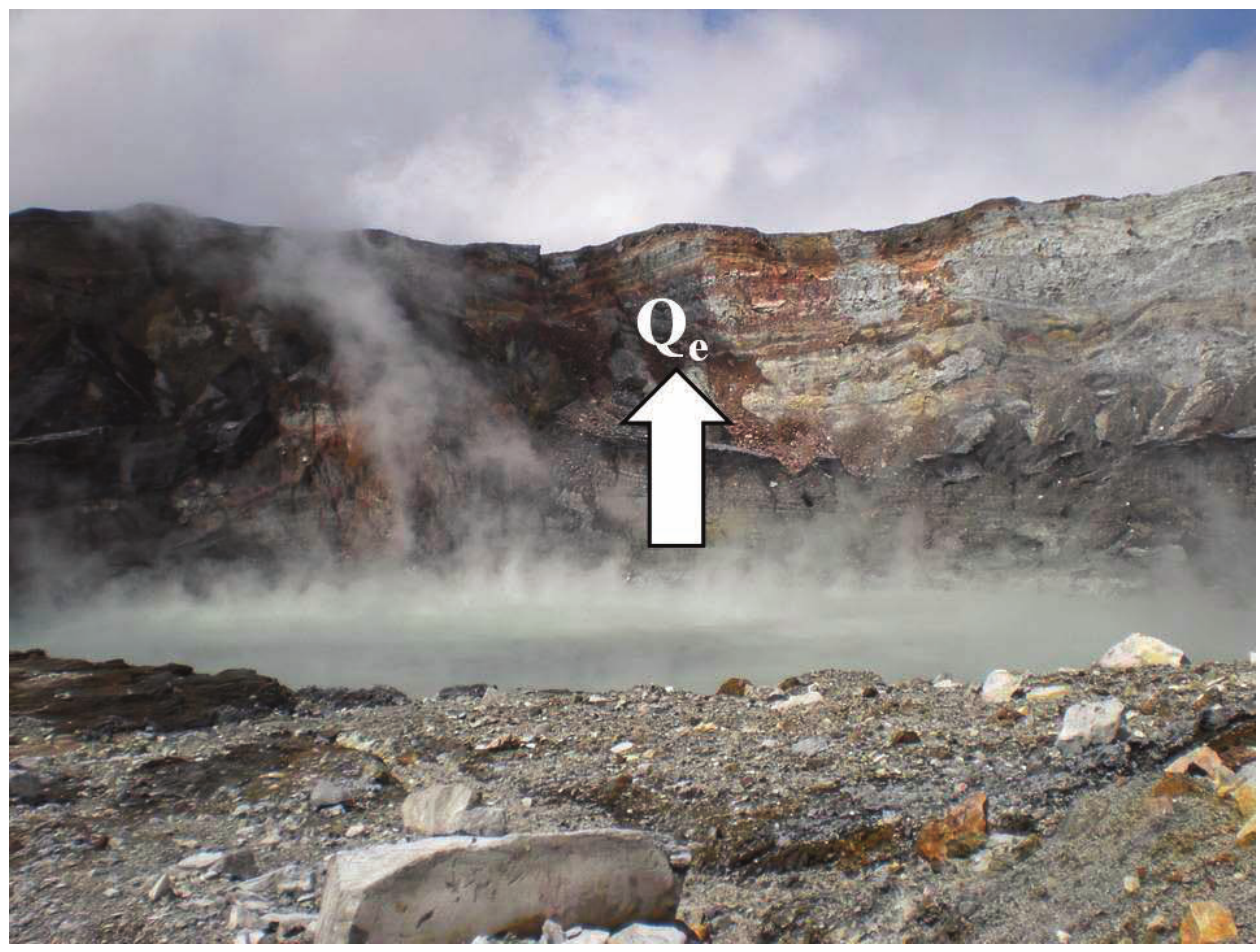
Figure 3. Evaporation (Q ) from Poás crater lake, Costa Rica (December 2009; photograph: D. Rouwet). The lake temperature was ~45 ˚C, while the e ambient temperature was ~10